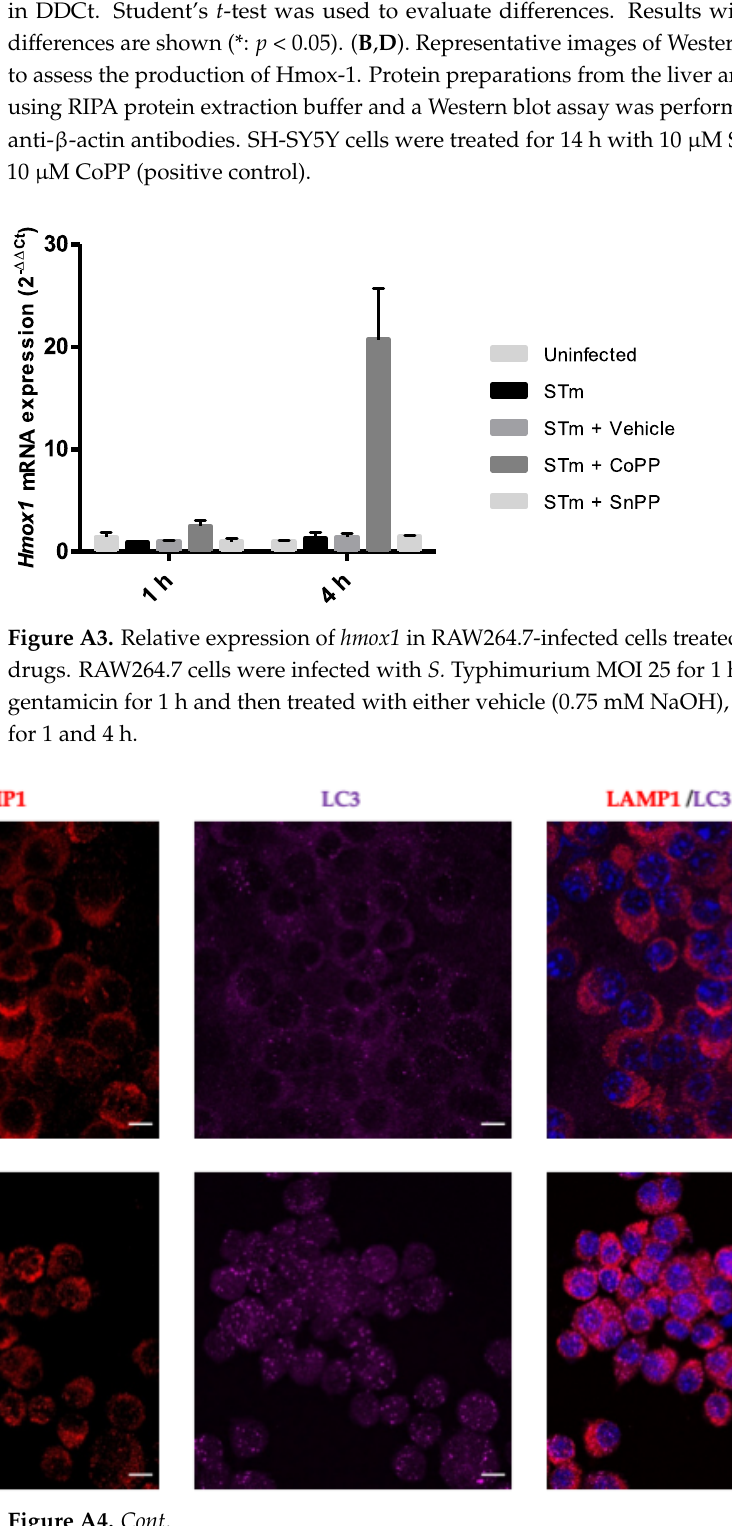
Figure A2. Evaluation of Hmox-1 transcription in tissues of S. Typhimurium-infected mice. Female